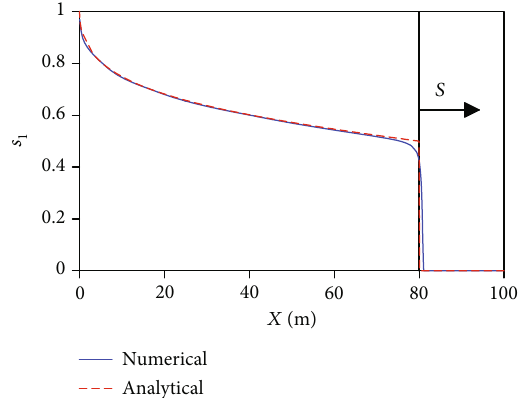
Figure 4: Distribution of the water saturation at t = 100 days. The solid and dashed curves correspond to the numerical and analytical solutions, respectively.